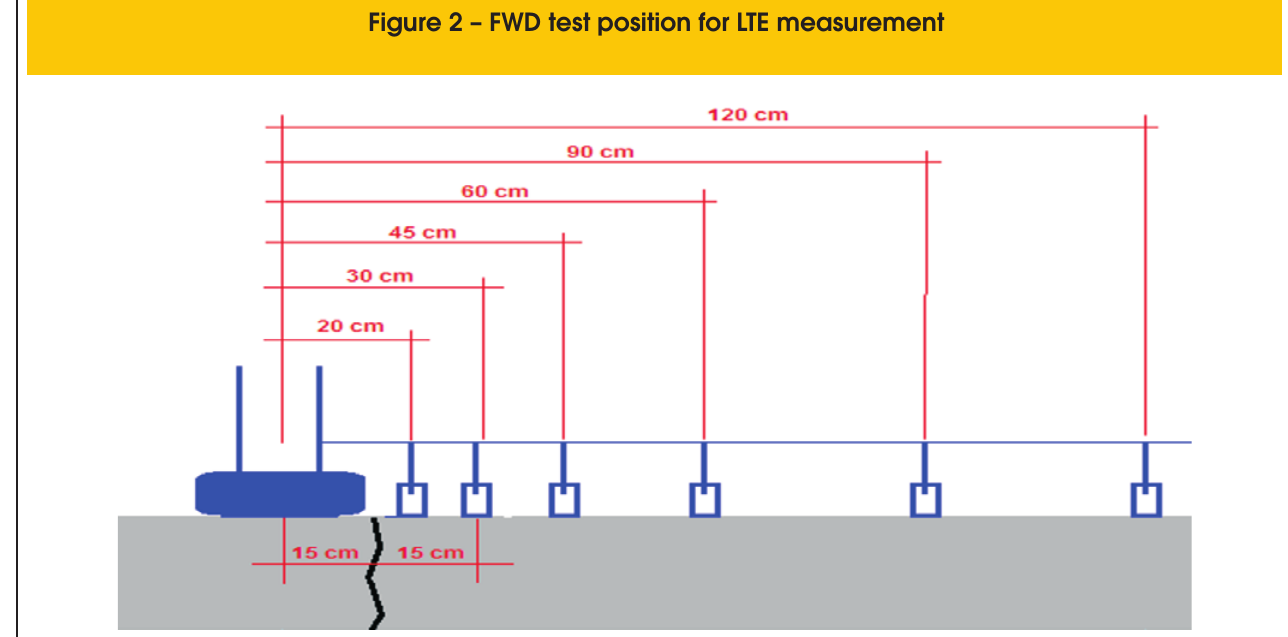
Figure 2 – FWD test position for LTE